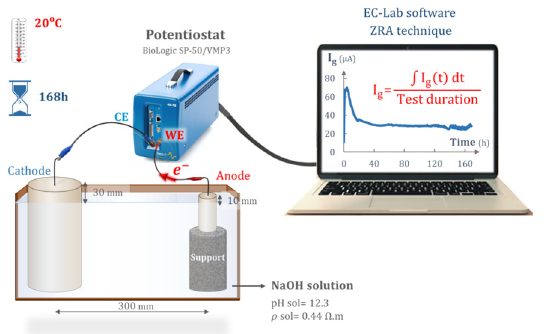
Figure 2. Cathode ‐ anode coupling and measurement of the galvanic current (from